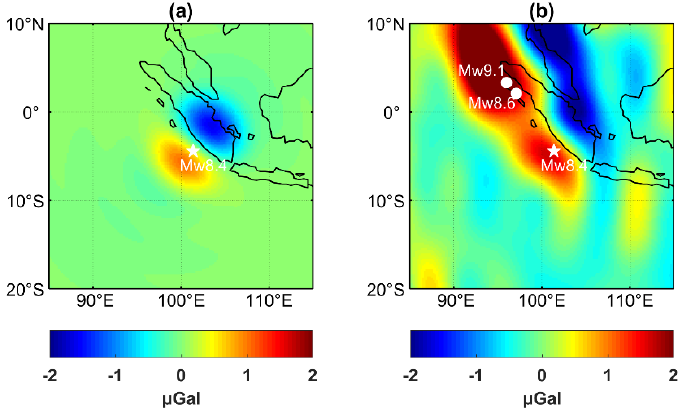
Figure 11. Coseismic gravity change in the 2007 Mw8.4 Bengkulu earthquake region. ( a ) The dislocation model prediction by USGS fault slip model. ( b ) Coseismic gravity changes from GRACE ob- servations.